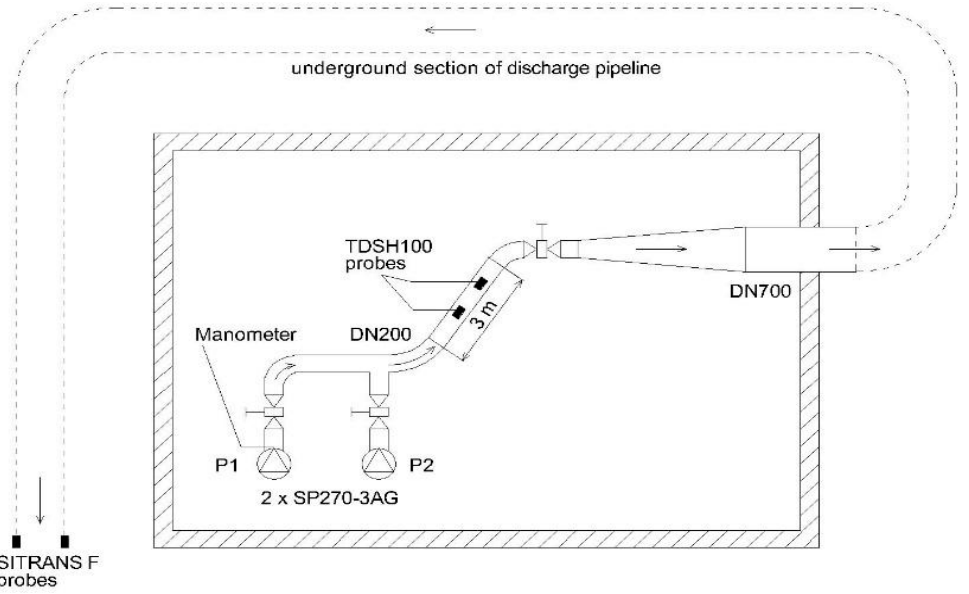
Figure 4. Simplified diagram of the pump station.